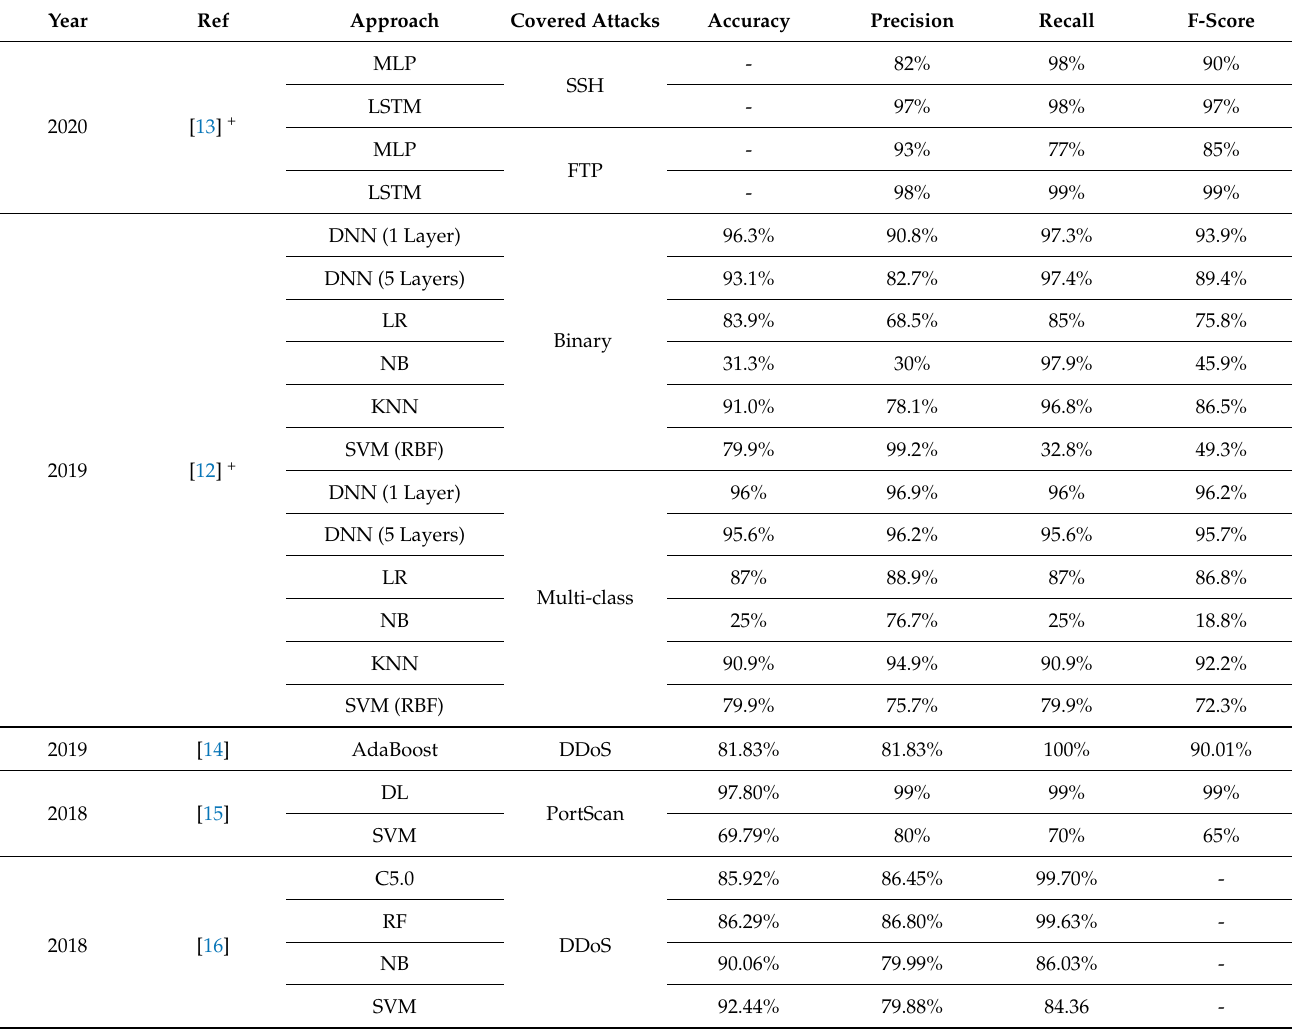
Table 1. CICIDS2017 recent papers performance summary